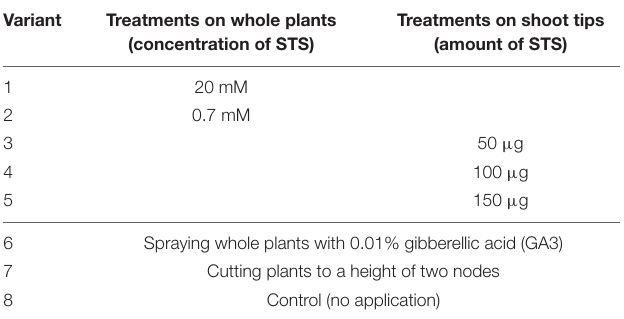
TABLE 1 | Treatments of the first experiment of male flowers induction on female plants of Cannabis sativa . Variant Treatments on whole plants Treatments on shoot tips (concentration of STS) (amount of